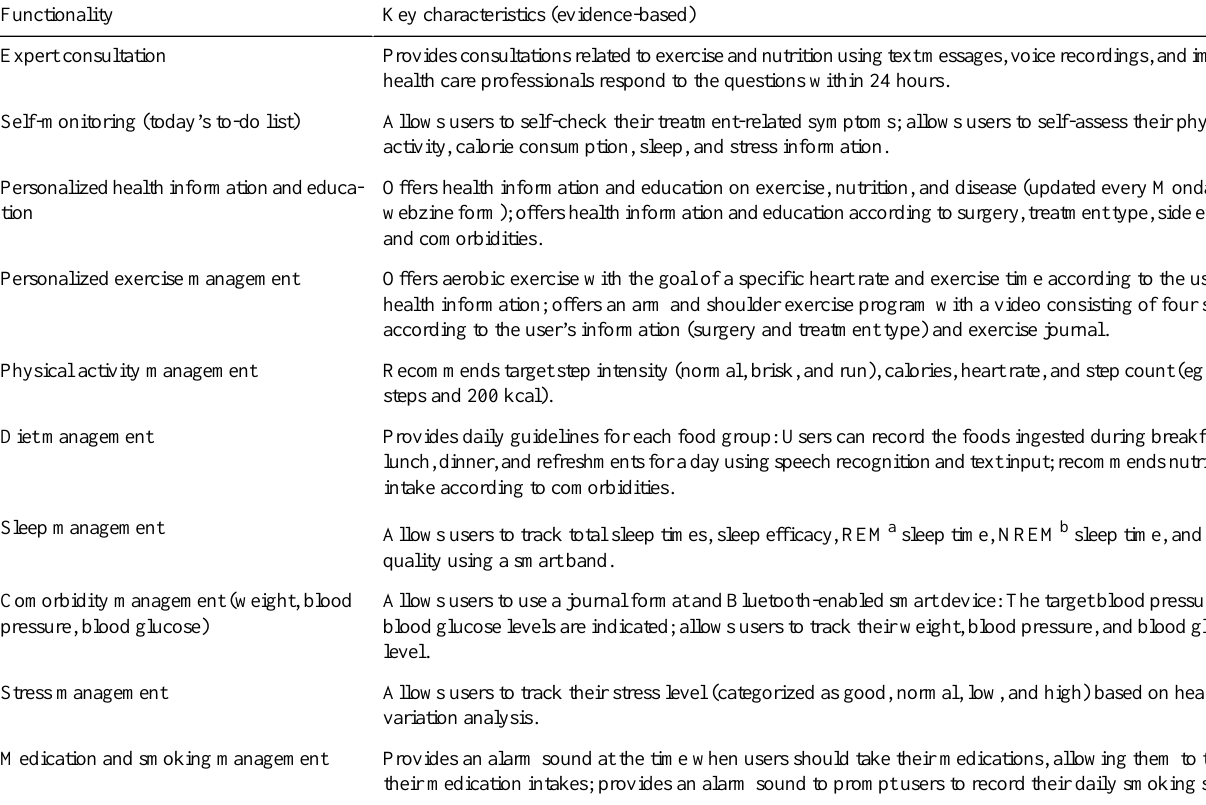
Table 1. Functionality and key characteristics of the mobile app. Key characteristics